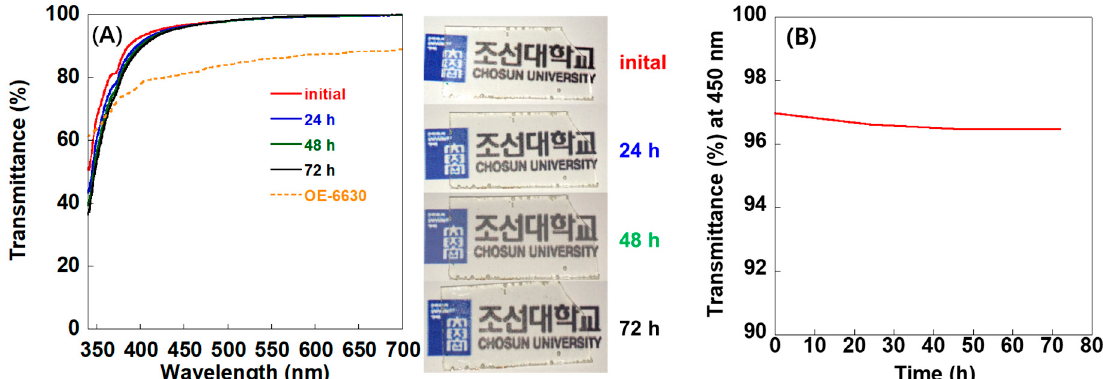
Figure 7. UV–Vis spectra of the silphenyl hybrimer (2 mm) before and after thermal aging at 180 °C for 72 h in air and the OE-6630 (Dow Corning, dotted orange line) ( A ). The photographs (middle) represent the pictures before and after the thermal aging test every 24 h. The change of transmittance of the PSH at 450 nm after thermal aging for 24, 48, and 72 h at 180 °C ( B ).